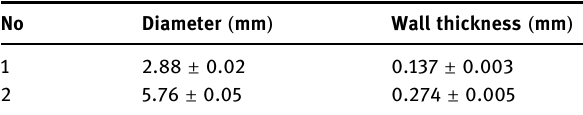
Table 1: The diameters and the wall thicknesses of